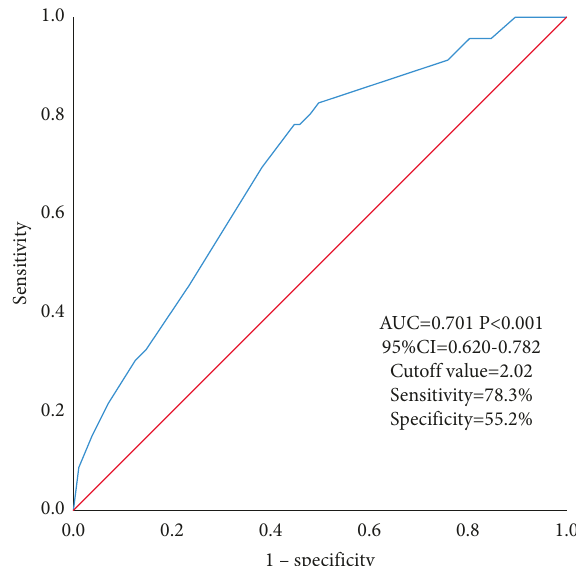
Figure 3: Receiver operating characteristic (ROC) curve to evaluate the combination prediction power of contralateral occult papillary thyroid cancer.